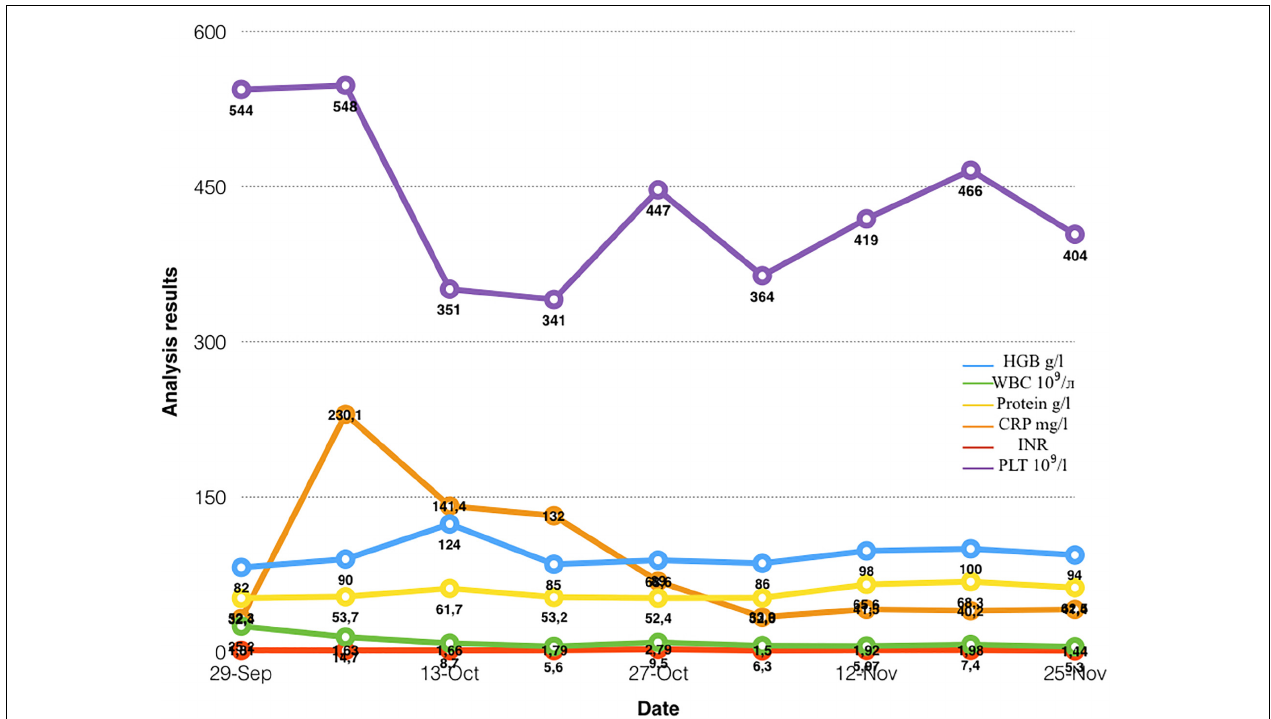
FIGURE 4 | The dynamics of tests from the moment of the patient’s admission to the discharge.